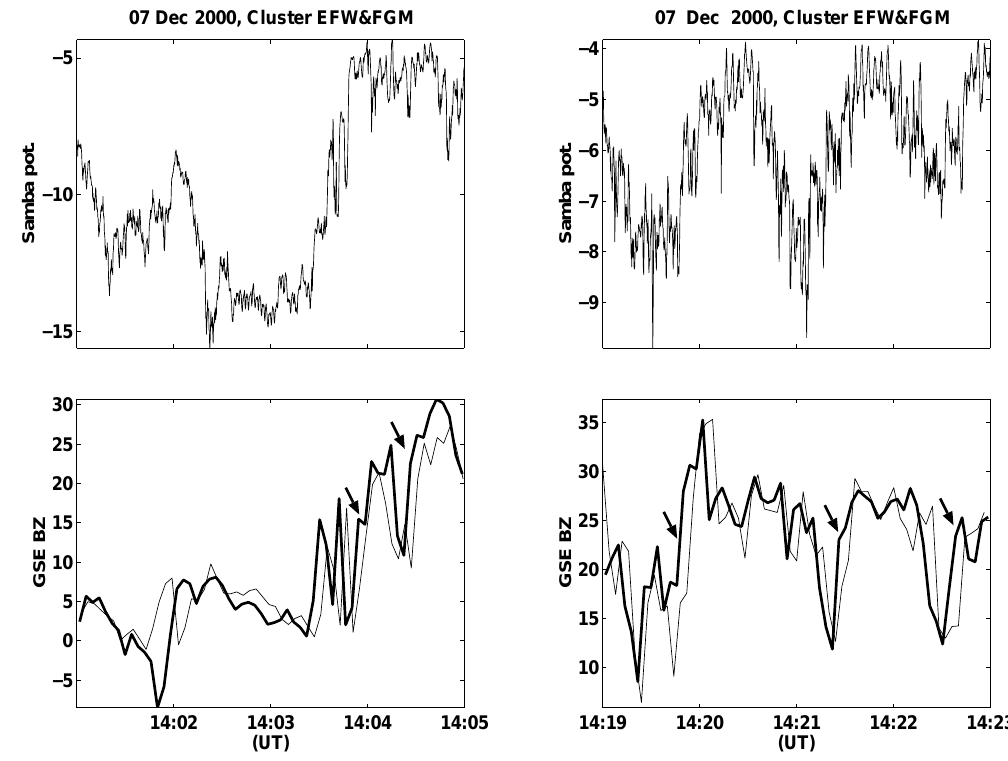
Fig. 9. Negative of the satellite potential of Samba and B Z (GSE), as recorded by Salsa (thick line) and Samba (thin line) FGMs. Left (right) panel shows an example recorded during the larger (smaller) potential variations. The arrows point to the differences in the curves which have been used when estimating the phase